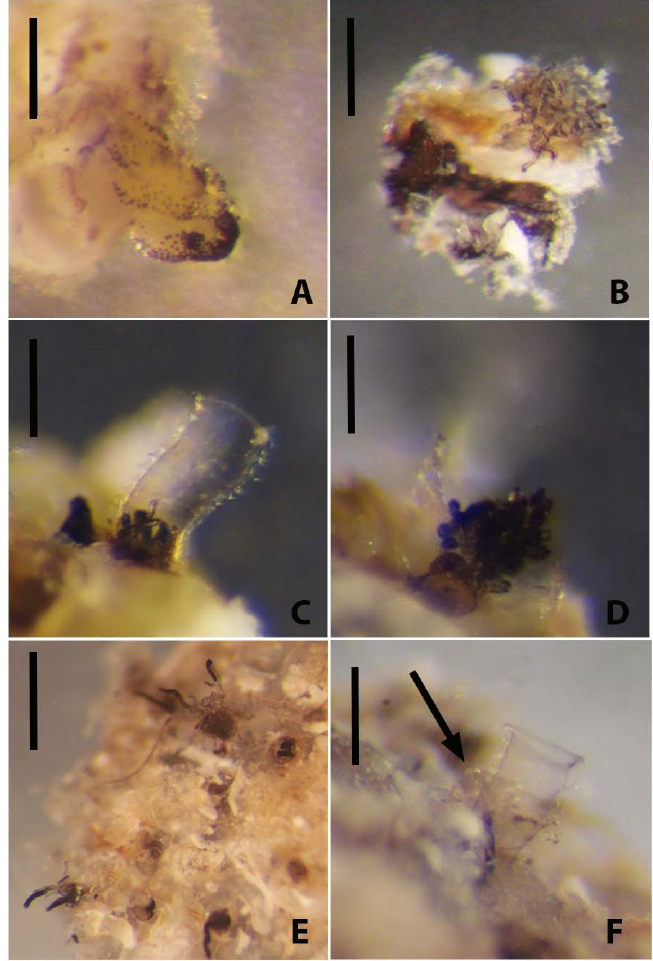
Figure 7. Experimental zooids and colonies. ( A ) A developing zooid survived eight days with no further development. ( B ) One of the two naked zooids attached to a creeping tube and stolon embedded in a bryozoan fragment. ( C , D ), Two zooids united by a common stolon and exposed following the fracturing of the bryozoan zoarium. ( C ) The zooid, able to descend into the host zoarium matrix, built a normal erect tube. ( D ) The exposed zooid built an unusual, flared tube. ( E ) After the removal of the original tubes, Rhabdopleura recondita zooids perched from the bryozoan zoarium apertures. ( F ) A new tube is re-secreted, arrow indicates the rim of the old tube. Scale bars 150 µm for ( A ), 250 µm for ( B – D ), and ( F ), and 450 µm for ( E ). One last colony was treated in vinegar to remove the calcium carbonate matrix of the bryozoan skeleton. Here we confirmed our previous observations and found that R. recondita is unusual in that it lacked a creeping tube with fuselli [31]. Instead, it lined the internal burrows of the bryozoan zoarium with smooth sheets of cortical material. The creeping tubes took the form of the walls of the burrows occurring in the host zoarium, and no zigzag fuselli were found, whereas the erect tubes, that project outwards from the bryozoan zoarium, had typical fuselli. Interestingly, a brood chamber was observed, made of a spirally formed smooth creeping tube that contained, from the outside to the inside, a degenerated female zooid and four larvae, from younger to older (Figure 8A). A degenerated female zooid is characterized by reduced tentacles and reduced internal organs, and sometimes a gonad is visible (Figure 8B). It is possible these individuals do not feed themselves